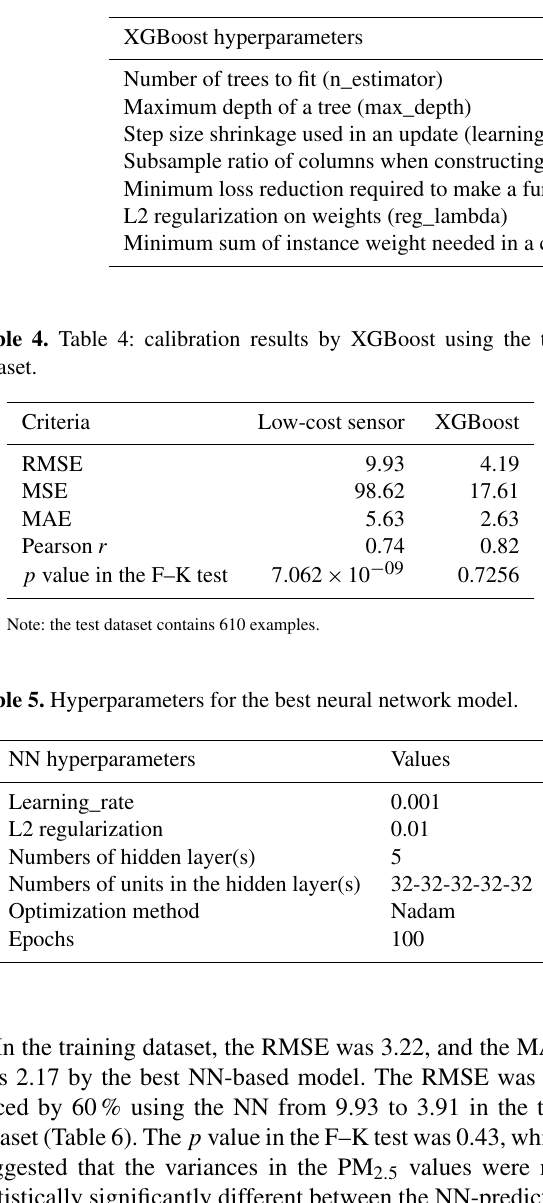
Table 3. Hyperparameters for the best XGBoost model.